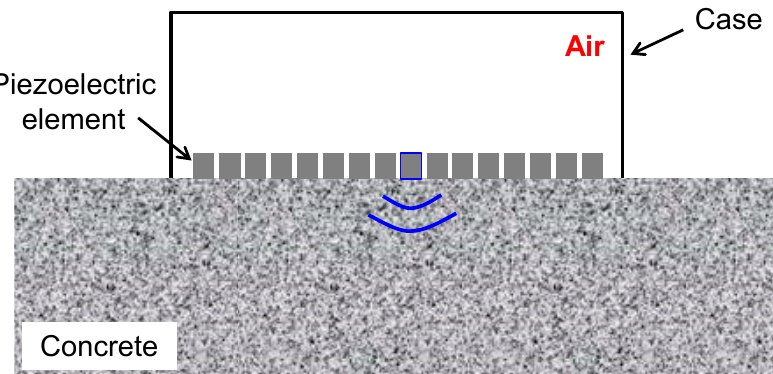
Figure 2. Proposed structure without filling materials or backing layer for LF array transducer.